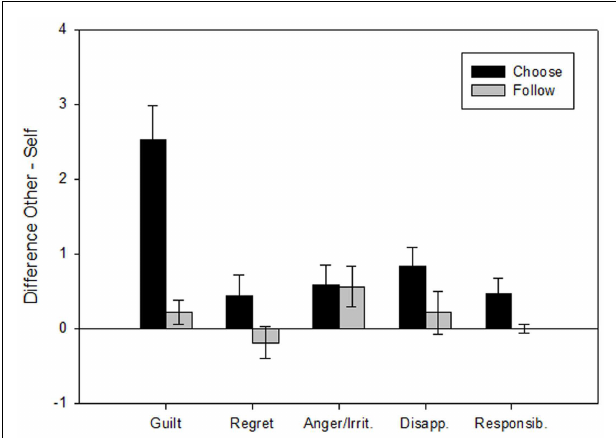
FIGURE 3 | Rating differences (means ± SEM) between “Other” and “Self” conditions (as an indicator of specificity to a social context) for guilt, regret, anger/irritation, disappointment, and responsibility after negatively evaluated trial outcomes. In the active “choose” conditions (black bars), guilt showed distinct social specificity, differing from all other emotions (all p < 0.001). In passive “follow” conditions (gray bars), no social specificity was observed for any of the